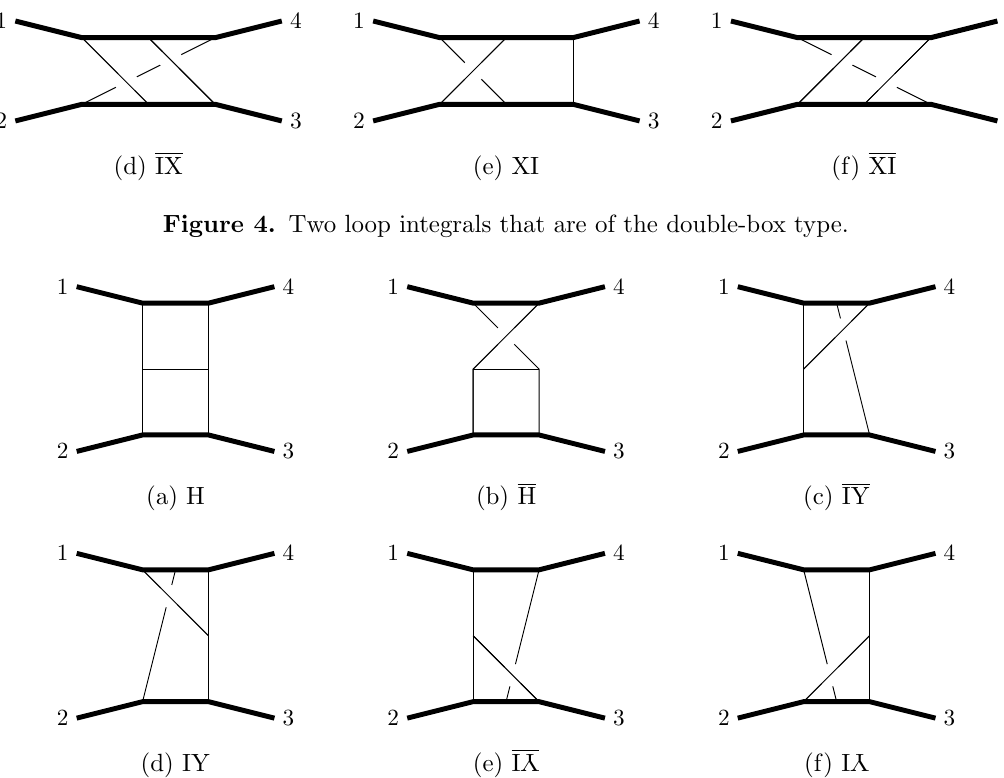
Figure 5. Two loop integrals that are not of the double-box